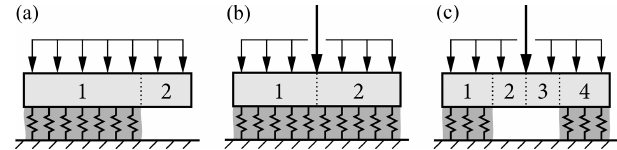
Figure 3. Snowpack configurations assembled from beam segments with boundary and transmission conditions: (a) PST, (b) skier load on the intact weak layer, (c) skier load on the weak layer with a crack. Weak-layer cracks are modeled by removing the support of the beam. For the sake of clarity only vertical loads are